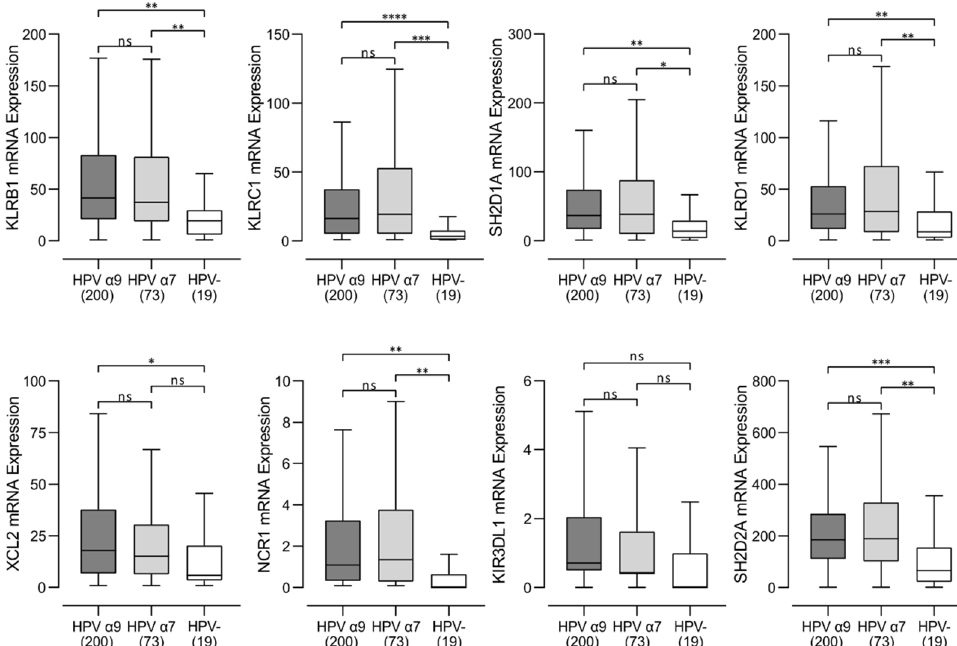
Figure 2. Transcript levels of NK cell marker genes in HPV-positive (HPV α 9 and HPV α 7) and HPV-negative (HPV-) cervical cancer. Normalized RNA-seq data was extracted from The Cancer Genome Atlas (TCGA) database for cervical cancer cohort. Numbers in brackets refer to the number of samples included in each analysis. **** p ≤ 0.0001, *** p ≤ 0.001, ** p ≤ 0.01, * p = 0.05, ns (not significant).